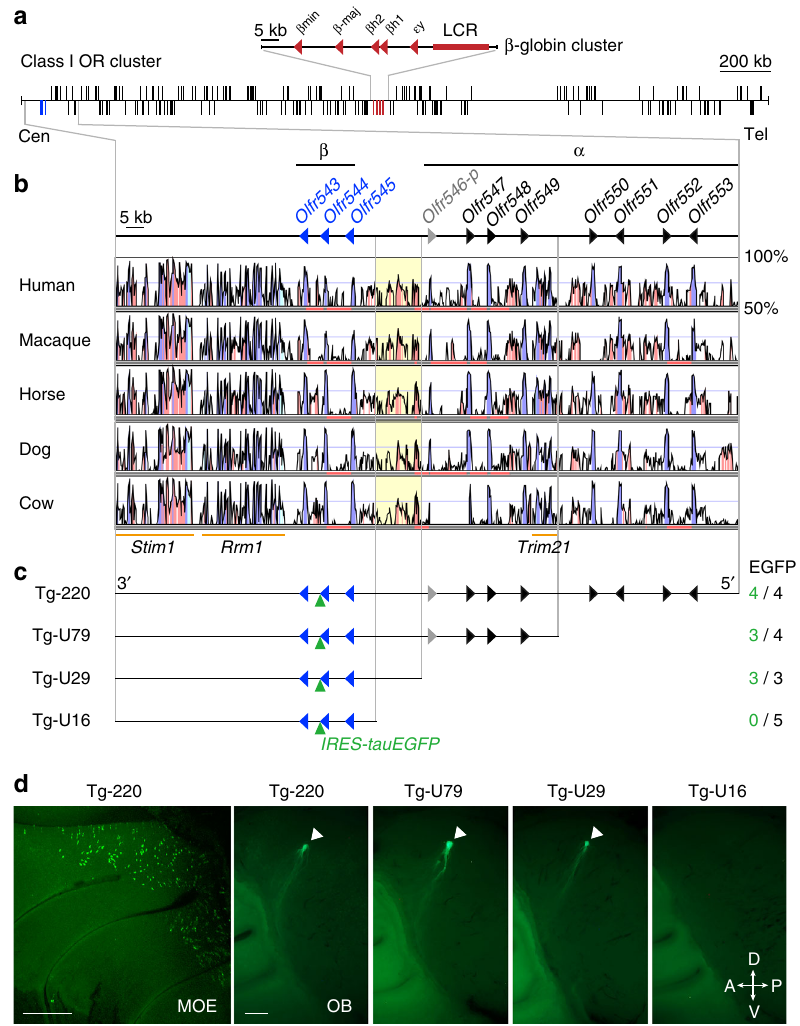
Fig. 1 Genomic organization of the class I OR cluster and identi fi cation of a cis- regulatory element. a Genomic region of the mouse class I OR gene cluster on chromosome 7. The vertical lines represent the positions of 158 class I OR genes ( black ) and 5 β -globin genes. Genes transcribed in the centromeric (Cen) to the telomeric (Tel) direction are drawn above the horizontal line ; those transcribed in the telomeric to centromeric direction are drawn below . The red arrowheads depict the transcriptional orientation of β -globin genes, and a red box represents the LCR of the β -globin cluster. b Nucleotide percent identity plots of the centromeric end of the class I OR gene clusters of mouse and other mammals using VISTA. The arrowheads indicate the transcriptional orientations of β -class I OR genes ( blue ) and α -class I OR genes (intact genes, black ; a pseudogene, gray ). Highly conserved regions ( > 70% identity) in coding exons, noncoding exons and intergenic regions are shown in blue , cyan , and pink , respectively. The orange bars indicate the non-OR genes Trim21, Rrm1 , and Stim1 . c Deletion series of Olfr544 transgenes. The number of EGFP-positive independent founders and lines among the total analyzed is shown on the right. d Representative whole-mount images of the medial aspect of the MOE (Tg-220) and the OB of Tg mice from the deletion series. Arrowheads indicate each glomerulus. The scale bar is 500 μ